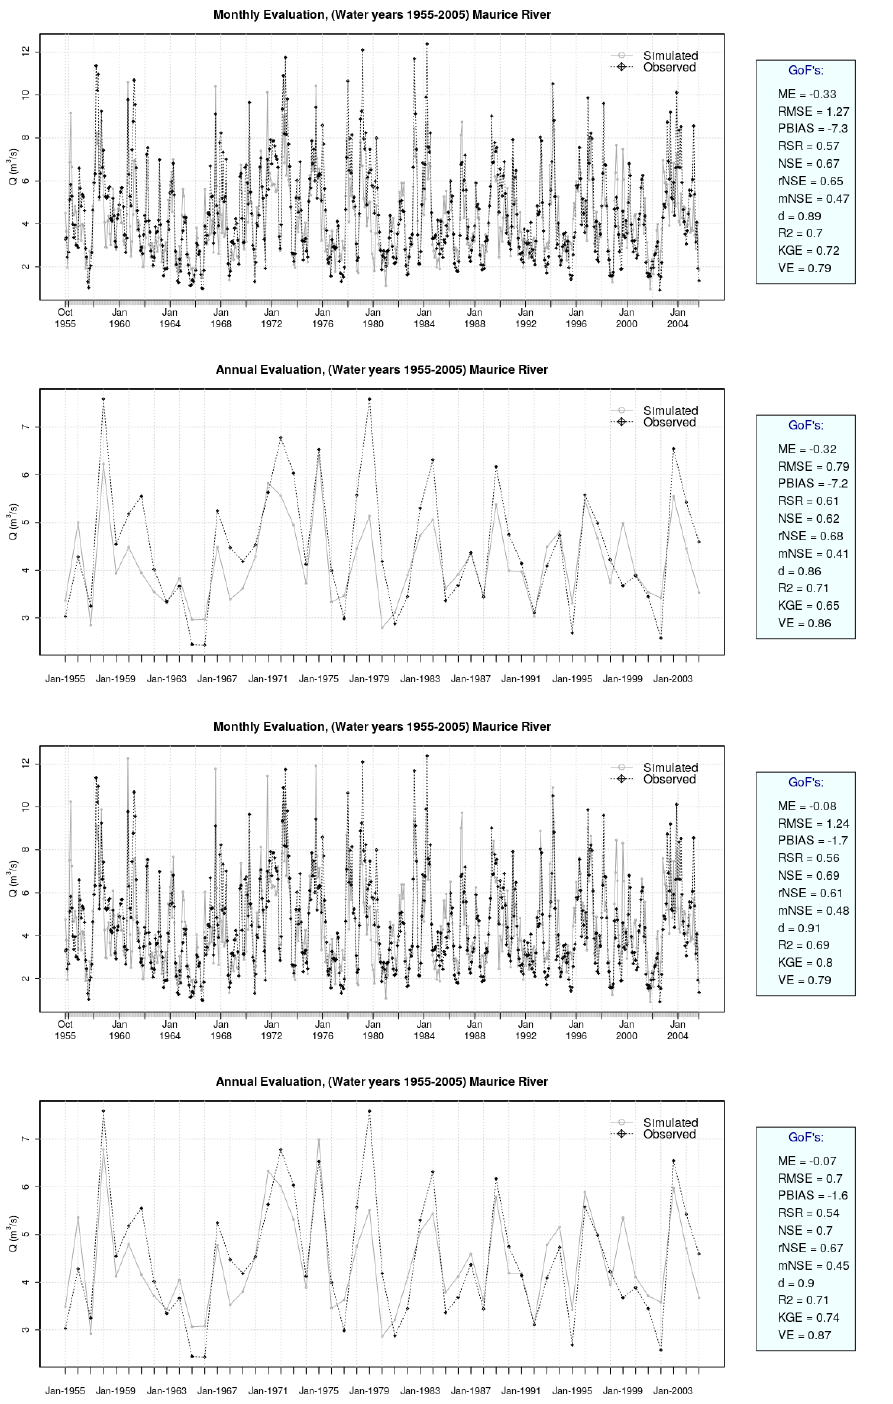
Figure 4. Goodness-of-fit for monthly mean flow (m 3 s − 1 ; top) and annual mean flow (second row) for uncorrected (UC) and monthly mean flow (third row) and annual mean flow (bottom) for bias-corrected (BC) PRMS simulations in the Maurice